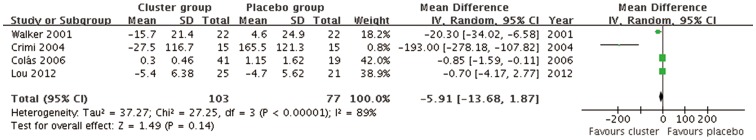
Meta-analysis of the RCTs comparing symptom scores between cluster group and placebo group.